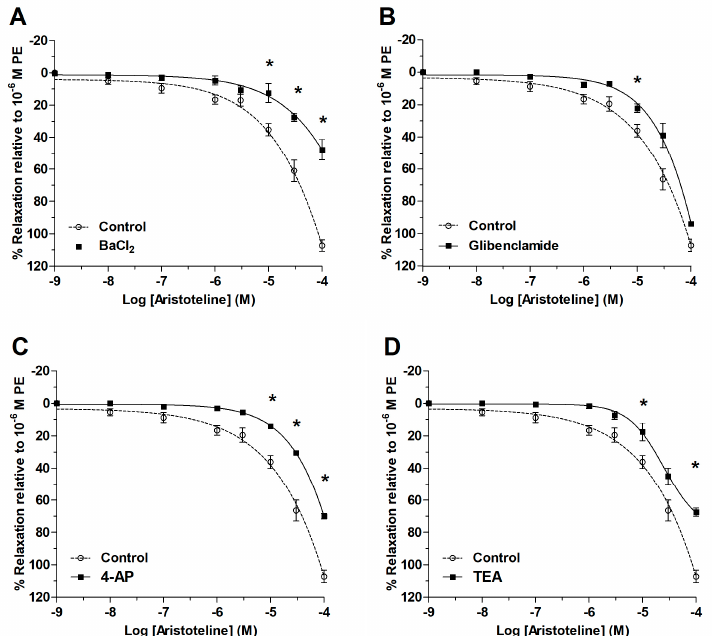
Figure 7. Evaluation of the ARI vasodilatation mechanism associated with potassium channels. Effect of ARI after the addition of BaCl 2 (10 µ M) as a blocker of inward rectifier potassium channels (Kir) is shown ( A ), glibenclamide (10 µ M) as blocker of adenosine triphosphate (ATP)-sensitive K + channels ( B ), 4-AP (1 mM) as a non-selective blocker of Kv channels ( C ) and tetraethylammonium (TEA) (1 mM) as a blocker of KCa channels ( D ). PE (1 µ M) was used to induce the contractile responses to the aortic rings. The determination of IC 50 were performed using non-linear regression and a repeated-measures two-way ANOVA to compare curves; n = 6. Statistically significant difference * p < 0.05 vs. Control.